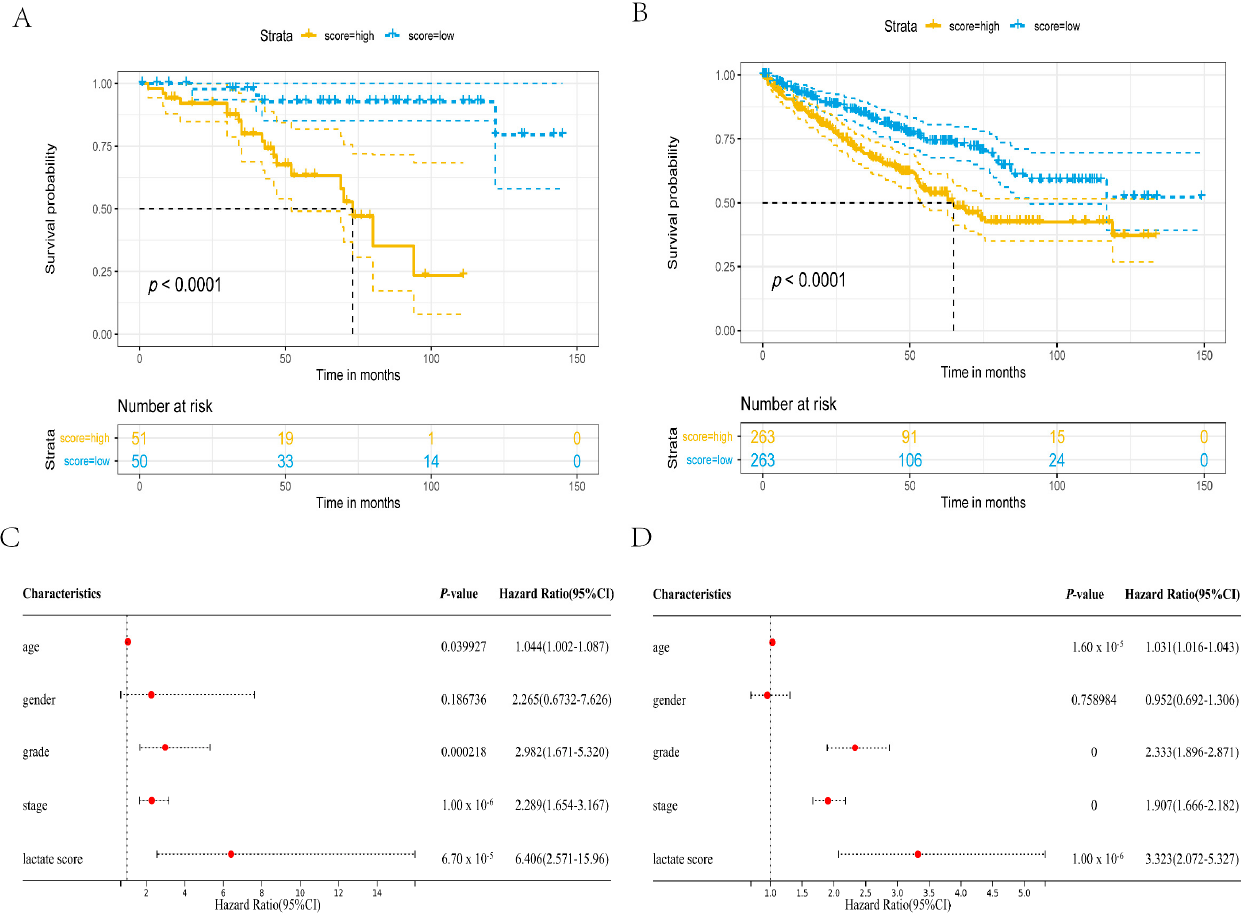
Figure 3. The three-gene prognostic model related to lactate metabolism and transporter can be used as a prognostic factor. ( A ) Kaplan–Meier survival analysis of overall survival stratified by risk score for ccRCC patients in the E-MTAB-1980 cohort. ( B ) Kaplan–Meier survival analysis to validate the prognostic model in the TCGA cohort. ( C ) Univariate Cox regression analysis of the E-MTAB-1980 cohort. ( D ) Univariate Cox regression analysis of the TCGA cohort.